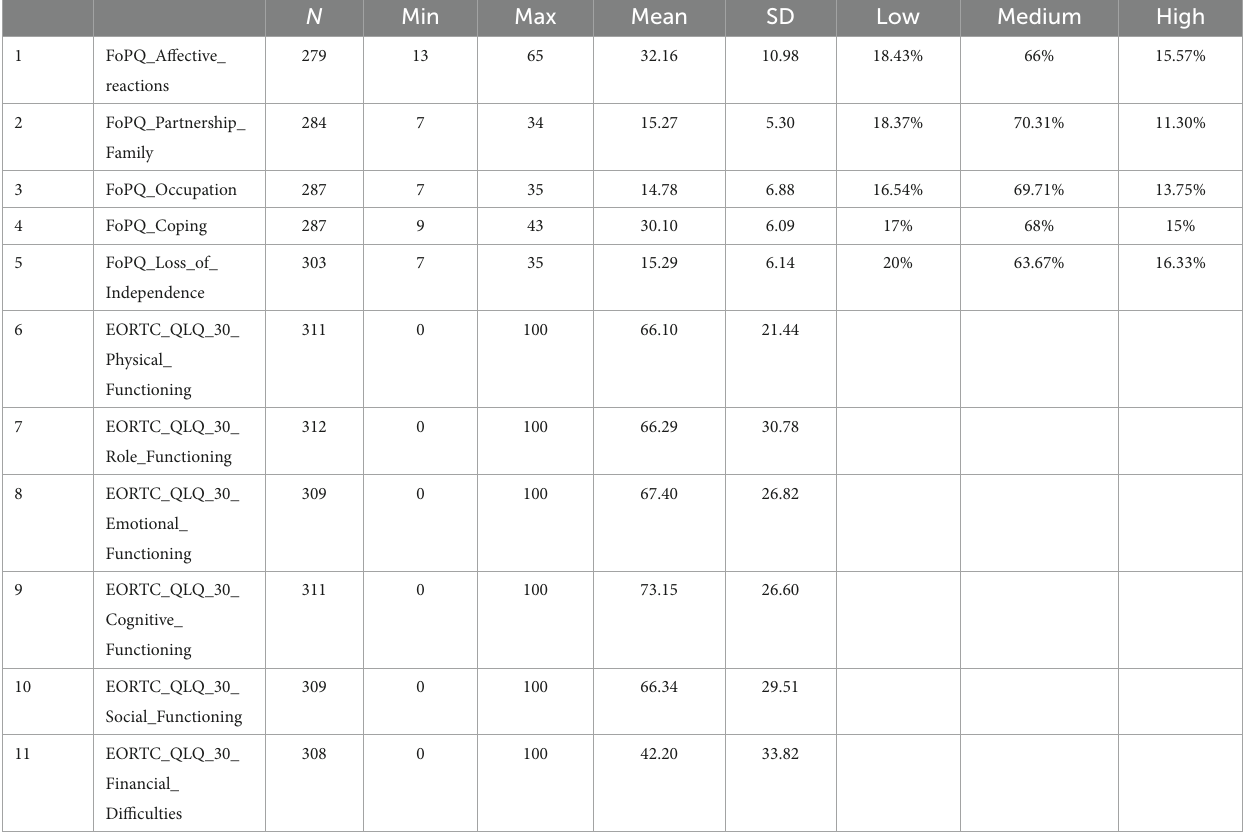
TABLE 1 Descriptive statistics (means, standard deviations, score ranges), with percentages of patients attaining low-medium-high levels of FoP.